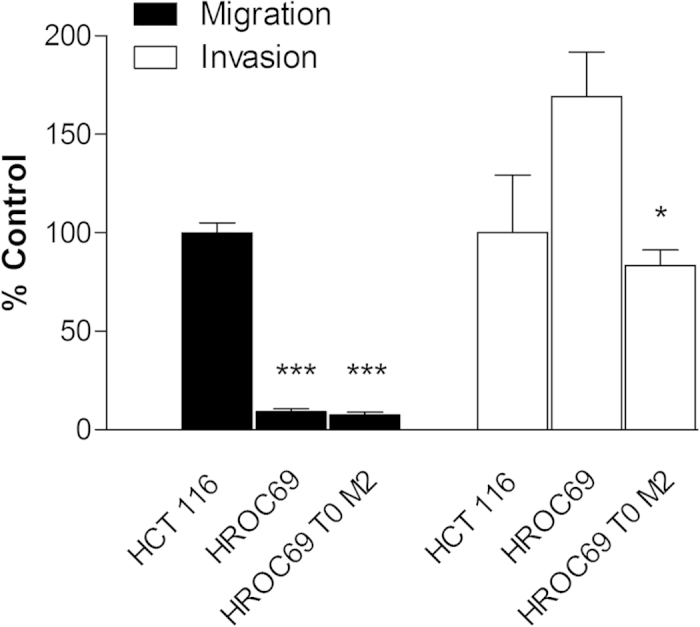
Migratory potential and invasiveness of HROC69 cells.Invasion and migration of the PDX-derived cell line HROC69 T0 M2 and the patient-derived cell line HROC69 in comparison to the reference cell line HCT116 was analysed. Cells were subjected to migration assay (Migration, black bars) and matrigel invasion assay (Invasion, white bars). For invasion and migration assays, cells were used at a density of 2 × 105 cells per upper Boyden chamber in a 24-well-plate format in 500 μl serum-free DMEM, respectively. In Boyden chamber assays DMEM containing 10% FCS was used as chemoattractant in the companion plate. Subsequently, cells were incubated for 72 hours. Values are means ± SEM of n = 4. ***P < 0.001, vs. HCT116 FL of the respective assay, ANOVA plus post hoc Bonferroni-test.